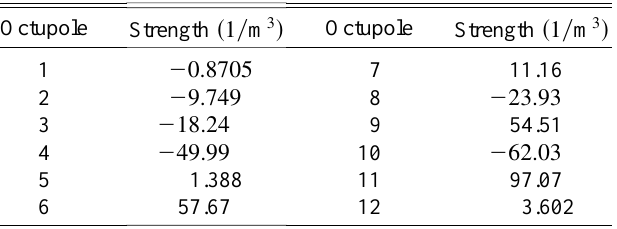
TABLE VII. The strengths of the octupoles of the final solu- tion. The octupoles are labeled from the starting point of the superperiod to the center (see Fig. 5). The strength is defined as d 3 B 1 s , where s is the length. 6 dr 3